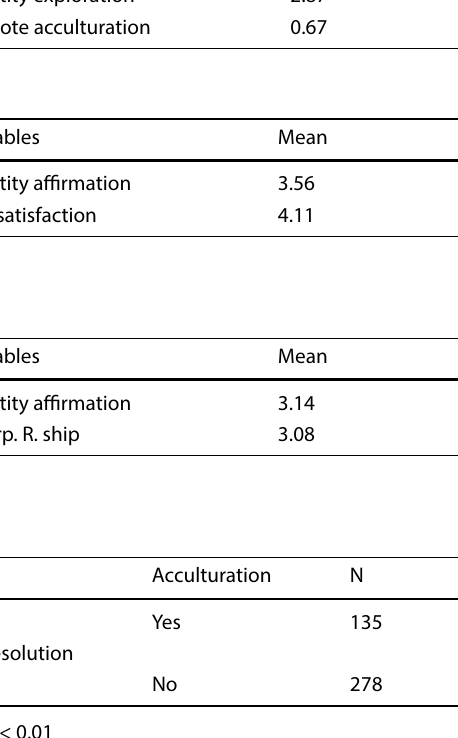
Table 3 The relationship between identity exploration and remote acculturation